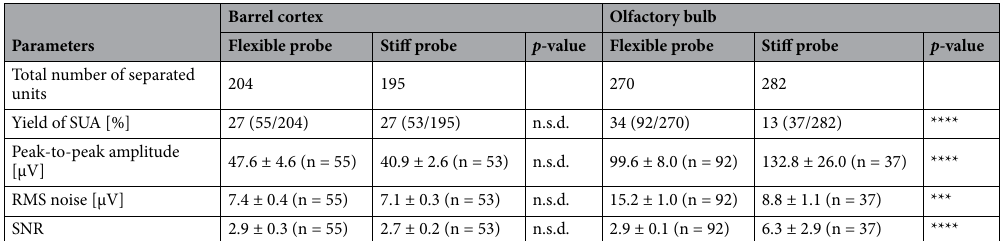
Table 1. Summary of single-unit activity (SUA) obtained from flexible and stiff intracortical probes grouped according to the two applications. Amplitudes, root-mean-square (RMS) noises and signal-to-noise ratios (SNRs), depicted as median ± 95 %CI, were compared employing the Mann-Whitney-U Test whereas the yield of SUA were compared using the chi-square test (*** for p ≤ 0.001, **** for p ≤ 0.0001). n.s.d = no significant